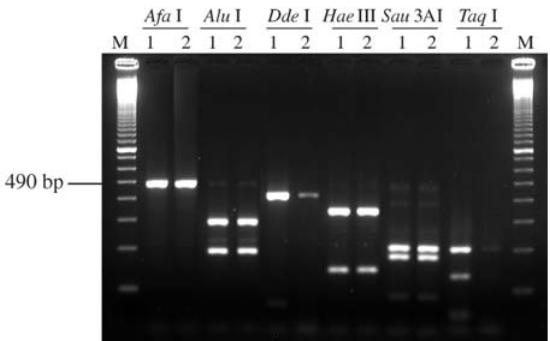
Figure 6 - PCR-RFLP profiles of Metarhizium anisopliae var. anisopliae strain 14 using the ITSMet14/ITS4 primer set with the restriction enzymes Afa I, Alu I, Dde I, Hae III , Sau 3A I and Taq I. 1 = DNA from a pure cul- ture of strain 14; 2 = DNA from larvae infected with strain 14. M = 100 bp DNA